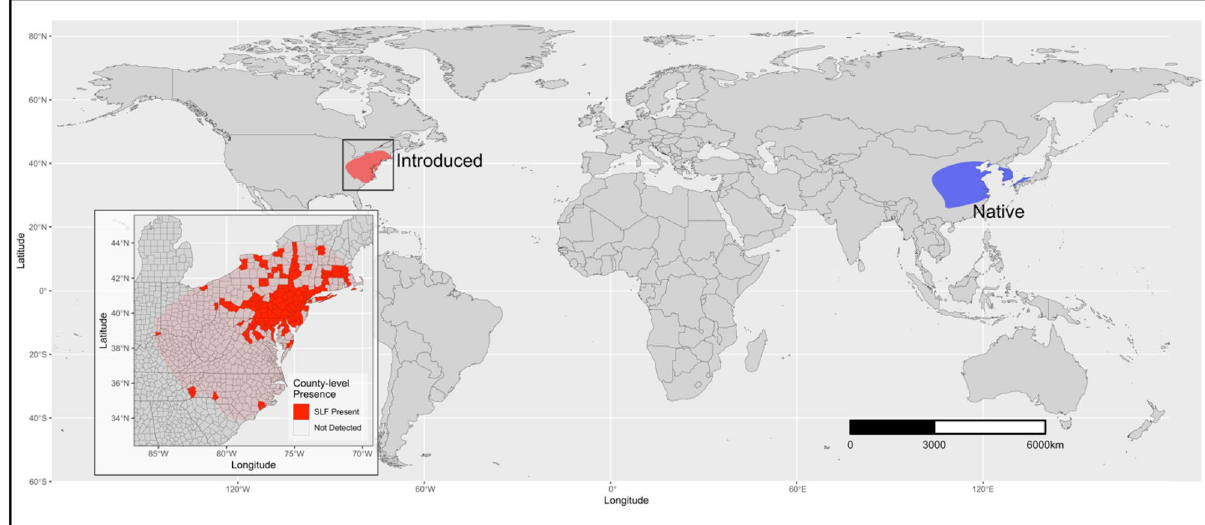
Figure 1. Map of global distribution of the spotted lanternfly in both its native range (blue) and introduced range (red) within eastern United States. Map inset shows zoomed in county-level spotted lanternfly presence. This map was made using the ‘ggplot2’ (ver. 3.3.6; https:// cran.r- proje ct. org/ web/ packa ges/ ggplo t2/ index. html) and ‘cowplot’ (ver. 1.0.0; https:// www. rdocu menta tion. org/ packa ges/ cowpl ot/ versi ons/1. 1.1) packages in